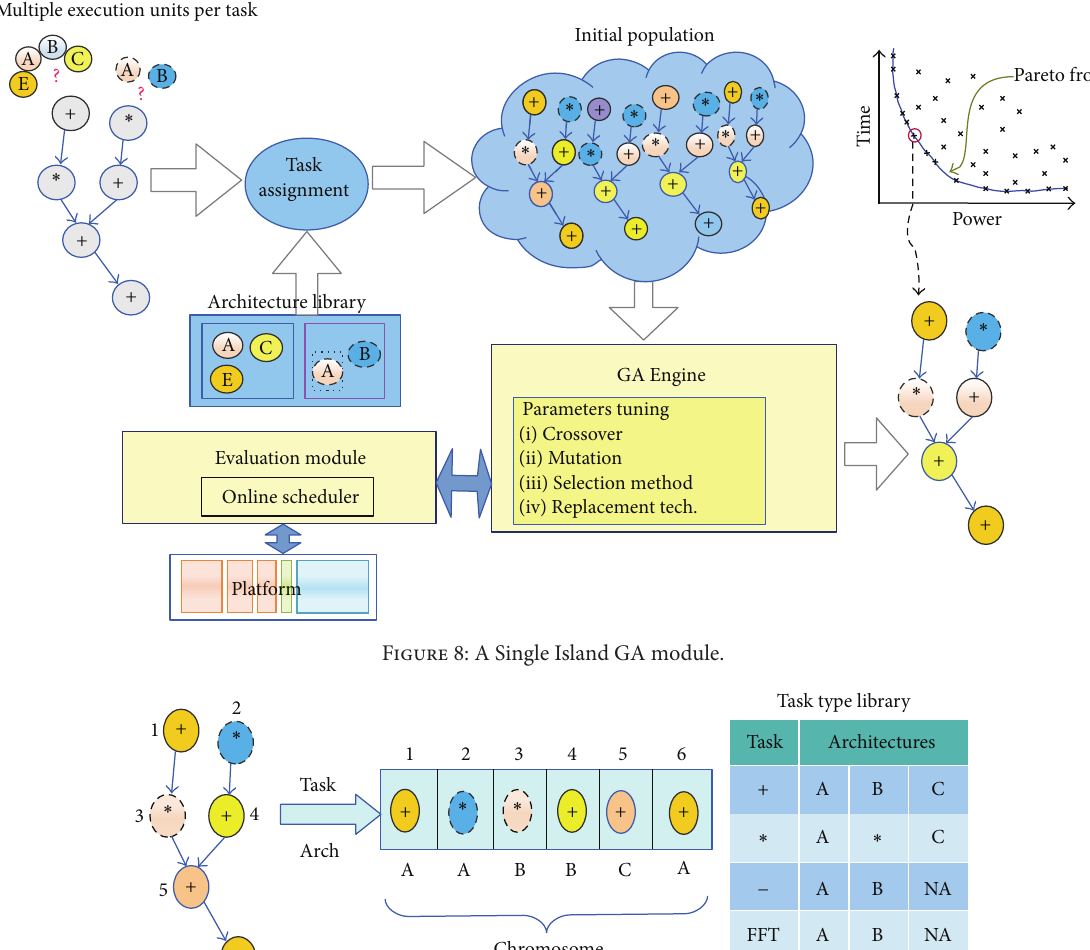
Figure 9: Task graph to chromosome mapping